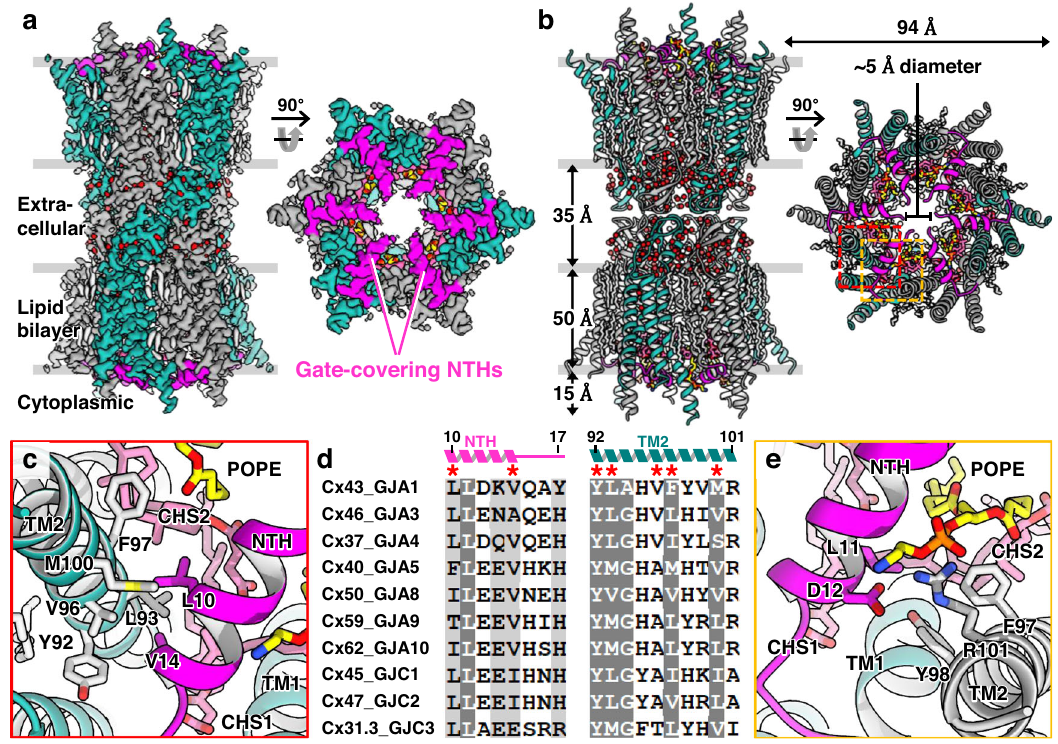
Fig. 2 | Structure of Cx43-M257 GJICh in GCN conformation. a Cryo-EM map densityofCx43-M257GJIChinPOPE/CHS(condition7)viewedfromthemembrane plane (left) and cytoplasmic side (right). The NTHs are colored magenta. Water moleculesareshownasredspheres. b Ribbonrepresentationofthestructurein( a ). c Detailed intramolecular hydrophobic interactions between NTH and TM2. The residuesinvolved inthese interactionsaredrawnassticksandlabeled. d Sequence